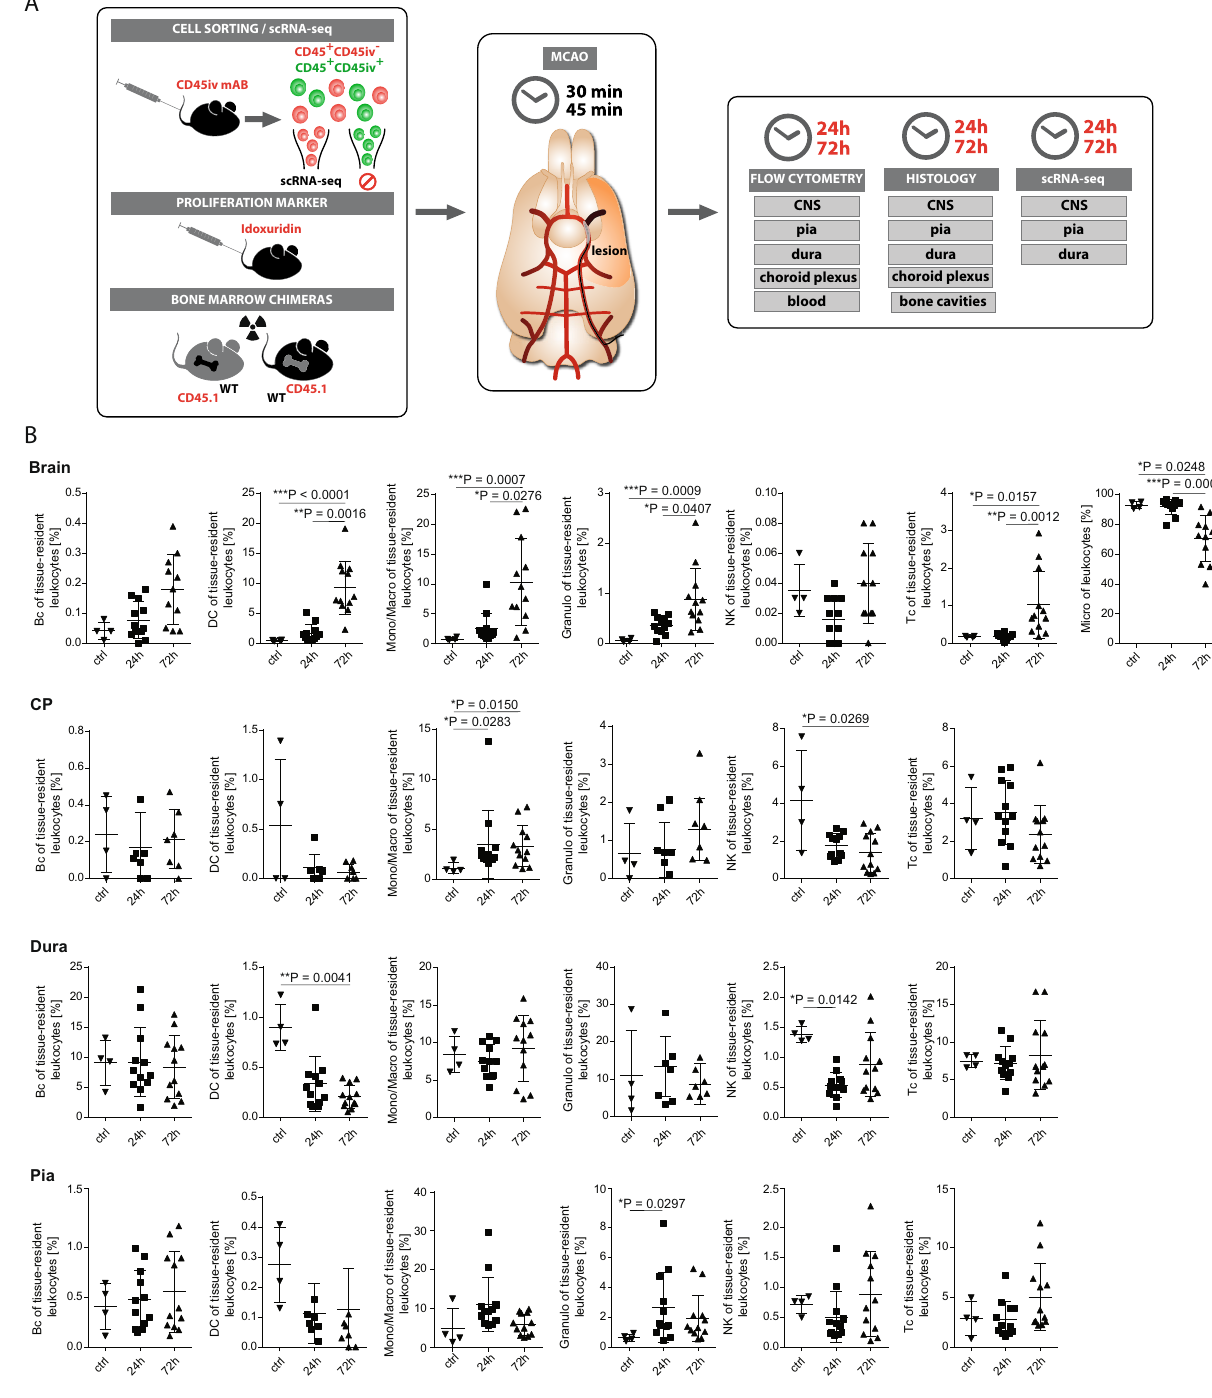
Fig. 1 Stroke affects leukocytes in a compartment-speci fi c fashion. A Scheme of the experimental approach. Middle cerebral artery occlusion (MCAO) (or sham-operated, as controls) was induced in wild-type (WT) mice for 30 or 45 min and mice were sacri fi ced 24 h or 72 h later (post ischemia). Prior to stroke induction, fl uorophore-labeled CD45 antibody (mAb) was injected intravenously (iv). After 5 min, mice were intracardially perfused and CD45 + - leukocytes negative for the CD45iv antibody (CD45 + CD45iv − ) then de fi ned as tissue-resident leukocytes were fl ow-sorted from central nervous system (CNS) parenchyma, pia, dura, choroid plexus (CP) and blood, and analyzed by fl ow cytometry and single-cell RNA-sequencing (scRNA-seq). Tissue sections were analyzed by immunohistochemistry. B Frequencies of Bc (B cells), DC (dendritic cells), Mono/Macro (Monocytes/Macrophages), Granulo (Granulocytes), NK (Natural killer cells), Tc (T cells) and Micro (Microglia) of tissue-resident leukocytes isolated out of the Brain, CP, Dura and Pia from sham-operated mice without stroke (ctrl), from mice 24 h post ischemia (24 h) and from mice 72 h post ischemia (72 h) analyzed by Flow Cytometry. n = 4 for ctrl, n = 12 for 24 h and 72 h. Data are presented as mean values± SD. Statistical signi fi cance was tested using Kruskal – Wallis test with Dunn ’ s post test. Not signi fi cant = not shown, * P ≤ 0.05, ** P ≤ 0.01, *** P ≤ 0.001. Source data for B are provided as a Source Data fi